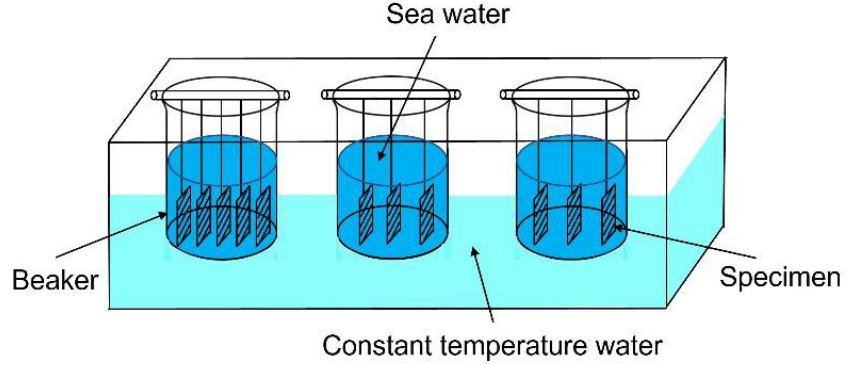
Figure 3. Micro-organism attachment experiment with